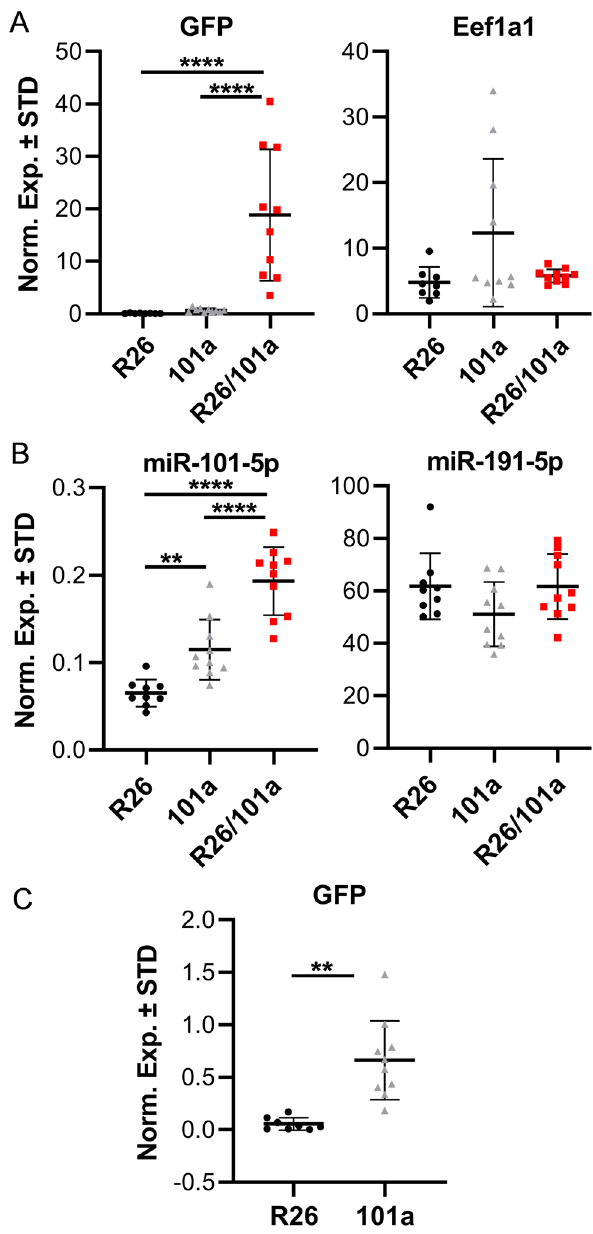
Figure 5. miR-101a expression is induced in male mice. Femora (left) were collected from R26 control, miR- 101a control, and miR-101a over-expressing (R26/101) male mice treated with doxycycline from inception to sacrifice (8 weeks). RNA ( A ) and miRNA ( B ) RT-qPCR analysis of all three mouse cohorts as well as RT-qPCR assessment for GFP in two control groups ( C ) (same values as in A) (n = 8 to 10, mean ± STD) are shown. **p < 0.01 and ****p < 0.0001. We note that miR-191-5p was arbitrarily included as a representative miRNA to reflect selectivity in modulations in the expression of miR-101-5p. MiRNA expression levels are presented using miR-103a-3p as internal control for